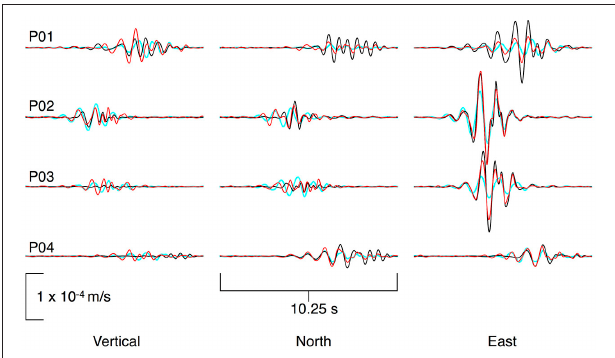
FIGURE 7 | Waveform fits for the representative LP event obtained from the phase-weighted stacks of 8,587 repeating events. Fits are for the E 2 min solution for the 6- components unconstrained inversion. Red lines indicate unconstrained -inversion synthetics, cyan lines are best-fitting constrained inversion synthetics, and black lines represent observed velocity